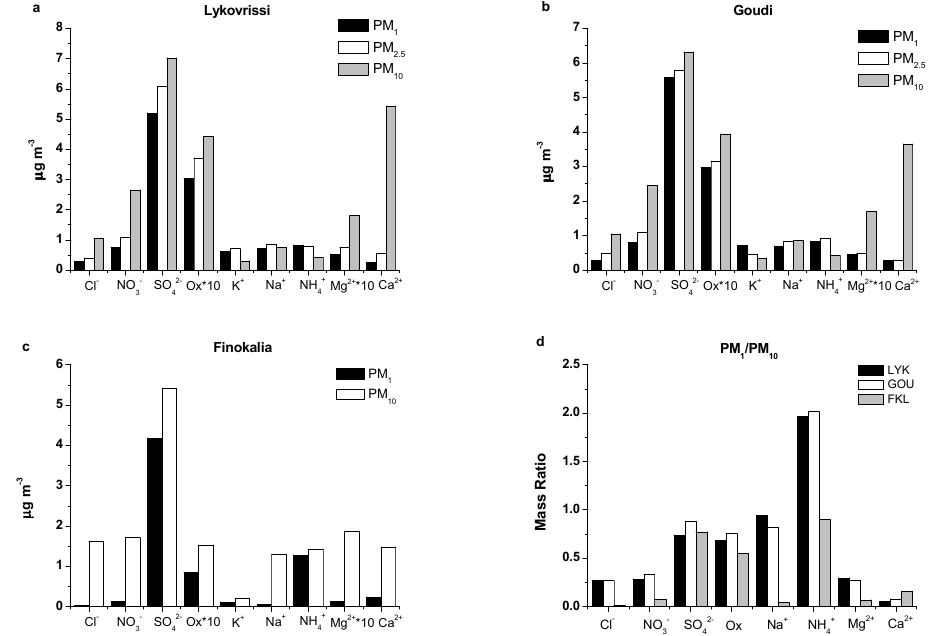
Fig. 6. Annual average concentrations (µgm − 3 ) of various ions for all three stations (a) LYK, (b) GOU, (c) FKL and (d) their PM 1 /PM 10 mass ratios. Figure 7 1